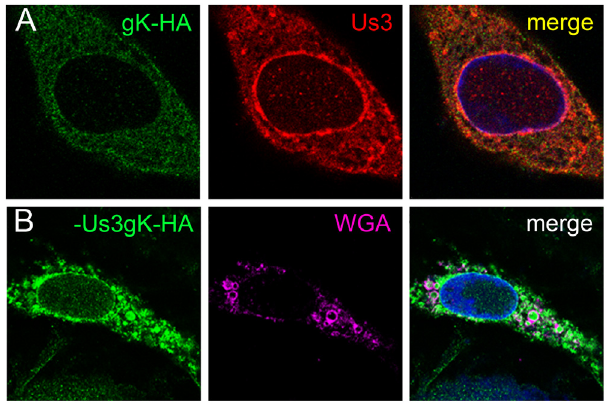
Figure 4. Immunofluorescence microscopy of Vero cell at 20 hpi with CK177gK-HA ( A ) or CK177 Δ Us3gK-HA ( B ). CK177gK-HA infected cells show fine but dense distribution of gK-HA over the entire cytoplasm, at the nuclear rim and, at a less extent, in the nucleus. Distribution of Us3 is similar though more intense at the nuclear rim. In the absence of Us3, gK-HA signals are markedly enhanced in all three compartments. gK-HA partly localizes with wheat germ agglutinin (WGA) as a marker for Golgi membranes. The fate of the Golgi complex is under investigation using specific markers.